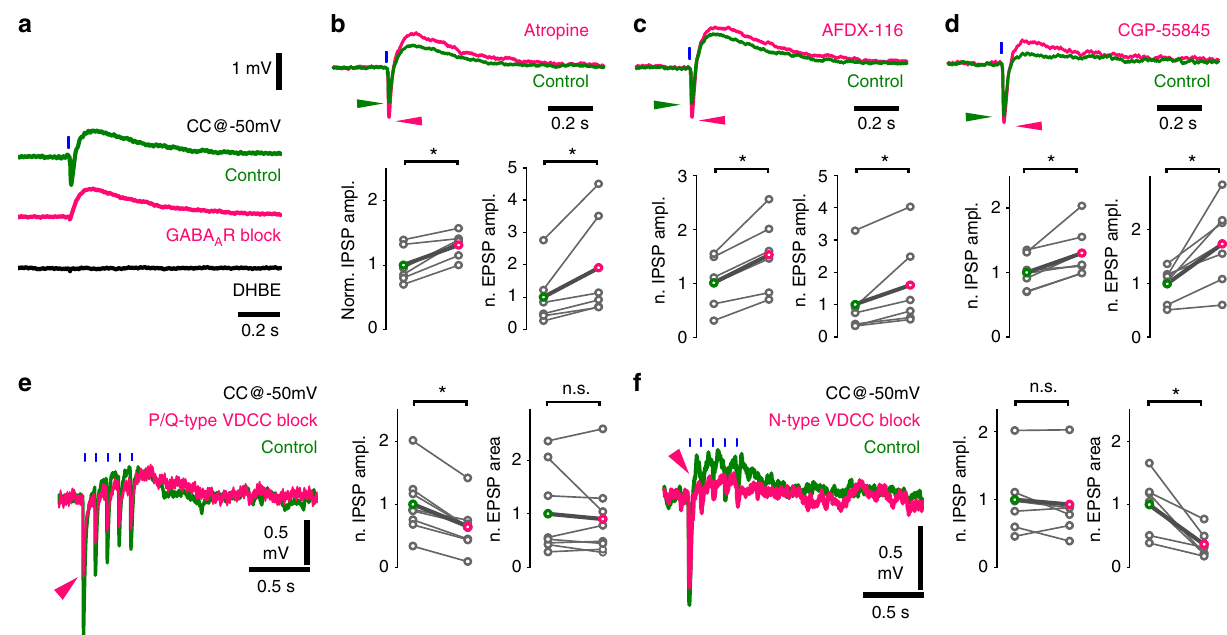
Fig. 5 Co-transmission of GABA and acetylcholine is cross-regulated by autoreceptors and mediated by distinct calcium channels. a Optical stimulations of cholinergic fi bres trigger composite membrane potential responses (average of 50 traces) of an inhibitory neuron recorded in str. lacunosum-moleculare (green). Cells were held at approximately − 50 mV to record hyperpolarising and depolarising components concurrently. Early hyperpolarization was con fi rmed to be of GABAergic origin by bath application of the GABA A R blocker gabazine (magenta, 10 µ M, which abolished quick hyperpolarization in 9 out of 9 tested cells), while the late depolarisation was con fi rmed to be cholinergic by the application of the alpha4-type nicotinic acetylcholine receptor blocker DH β E (black, 1 µ M, which abolished depolarisation in 5 out of 5 tested cells). Cells with identi fi able nicotinic responses were used to further investigate the properties of GABA and acetylcholine release from cholinergic fi bres. b Increase in GABAergic response after AChR block (Fig. 3d) suggested that presynaptic muscarinic receptors cross-modulated GABA (and possibly ACh) release from cholinergic fi bres. Therefore, putative presynaptic muscarinic receptors were selectively inhibited via bath application of atropine ( n = 6), which led to a signi fi cant increase in amplitude of both the GABAergic hyperpolarization and nicotinic depolarisation (green, see Supplementary Note 8). c Bath application of the selective M2 antagonist AFDX- 116 (10 µ M, n = 6) resulted in changes similar to that of atropine application (for data see Supplementary Note 8). d Blocking GABA B Rs with CGP-55845 (1 µ M, n = 7) also resulted in increased GABAergic and cholinergic responses suggesting a dual modulatory role (for data see Supplementary Note 8). e , f Testing roles of distinct voltage-dependent calcium channels (VDCC) in release of GABA and ACh . e Blockade of P/Q-type VDCC, using selective antagonist ω -agatoxin (1 µ M, puff application), reliably decreased GABAergic response component but did not alter cholinergic component. At control conditions, 5 short (1 ms) light pulses at 10 Hz evoked a composite event of GABAergic hyperpolarization and cholinergic depolarisation (green, average of 20 traces). In response to ω -agatoxin application (magenta, n = 9), the GABAergic component (measured as IPSP amplitude) decreased robustly (magenta arrowhead) and the cholinergic component (measured as EPSP area) showed no change (for details see Supplementary Note 8). f Blockade of N- type VDCC, using selective blocker ω -conotoxin (1 µ M), reliably reduced cholinergic response component ( n = 6) but left GABAergic